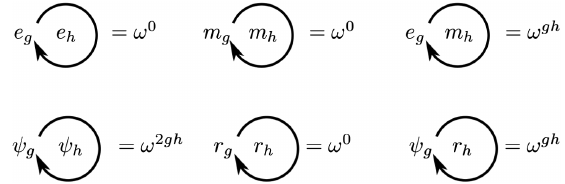
FIG. 3. Phases obtained by braiding the e and m excitations of the D ð Z 4 Þ model around each other (top), and by braiding the excitations ψ and r of the transformed stabilizers around each other